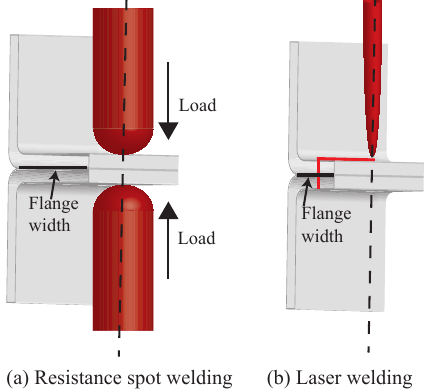
Figure 2. A schematic showing the flange width required in the case of: ( a ) resistance spot welding and ( b ) laser